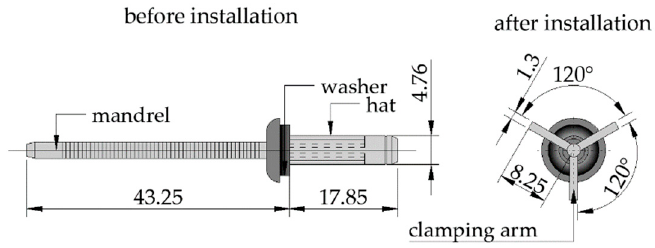
Figure 6. Geometrical parameters of the aluminum blind rivet with three clamping arms. The uplift static load was applied to the blind rivet by the loading cell without eccentrics with a speed of 2 mm/min. During the test, the load and the displacement of both the unit cell and the bottom facing of the sandwich beam were measured. Figure 7 includes the scheme of the test bed and a photo from the laboratory test.